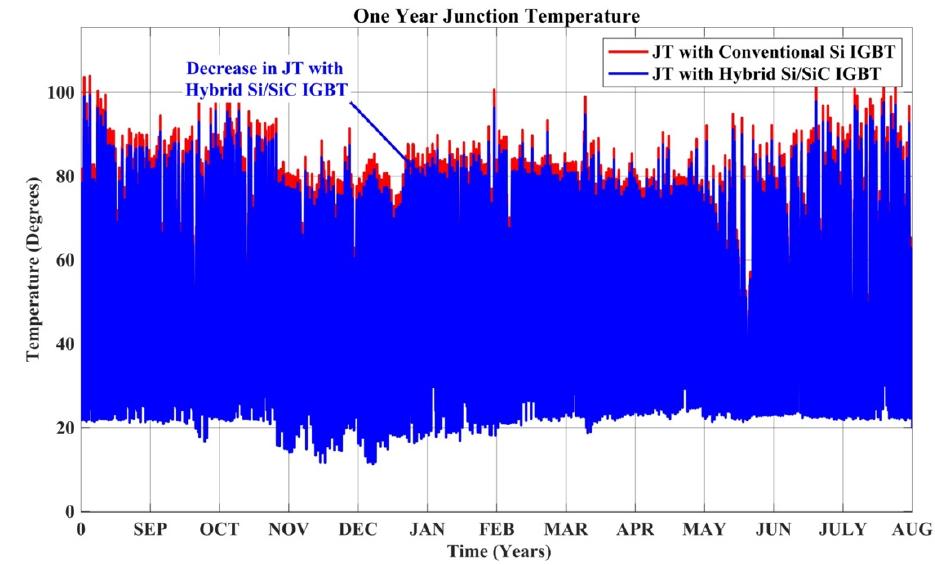
Figure 6. Yearly T j in India.